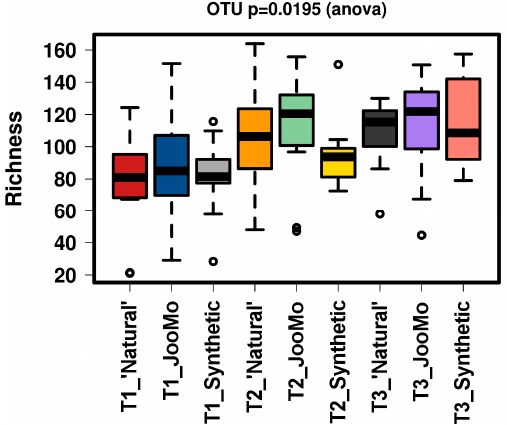
Figure 1. Chao1 of the different time points per group. There is a significant increase in diversity in all groups over time. The samples were normalised to a read depth of 534 sequences. Table 1. Numerical values of diversity for Figure 1 box plots.